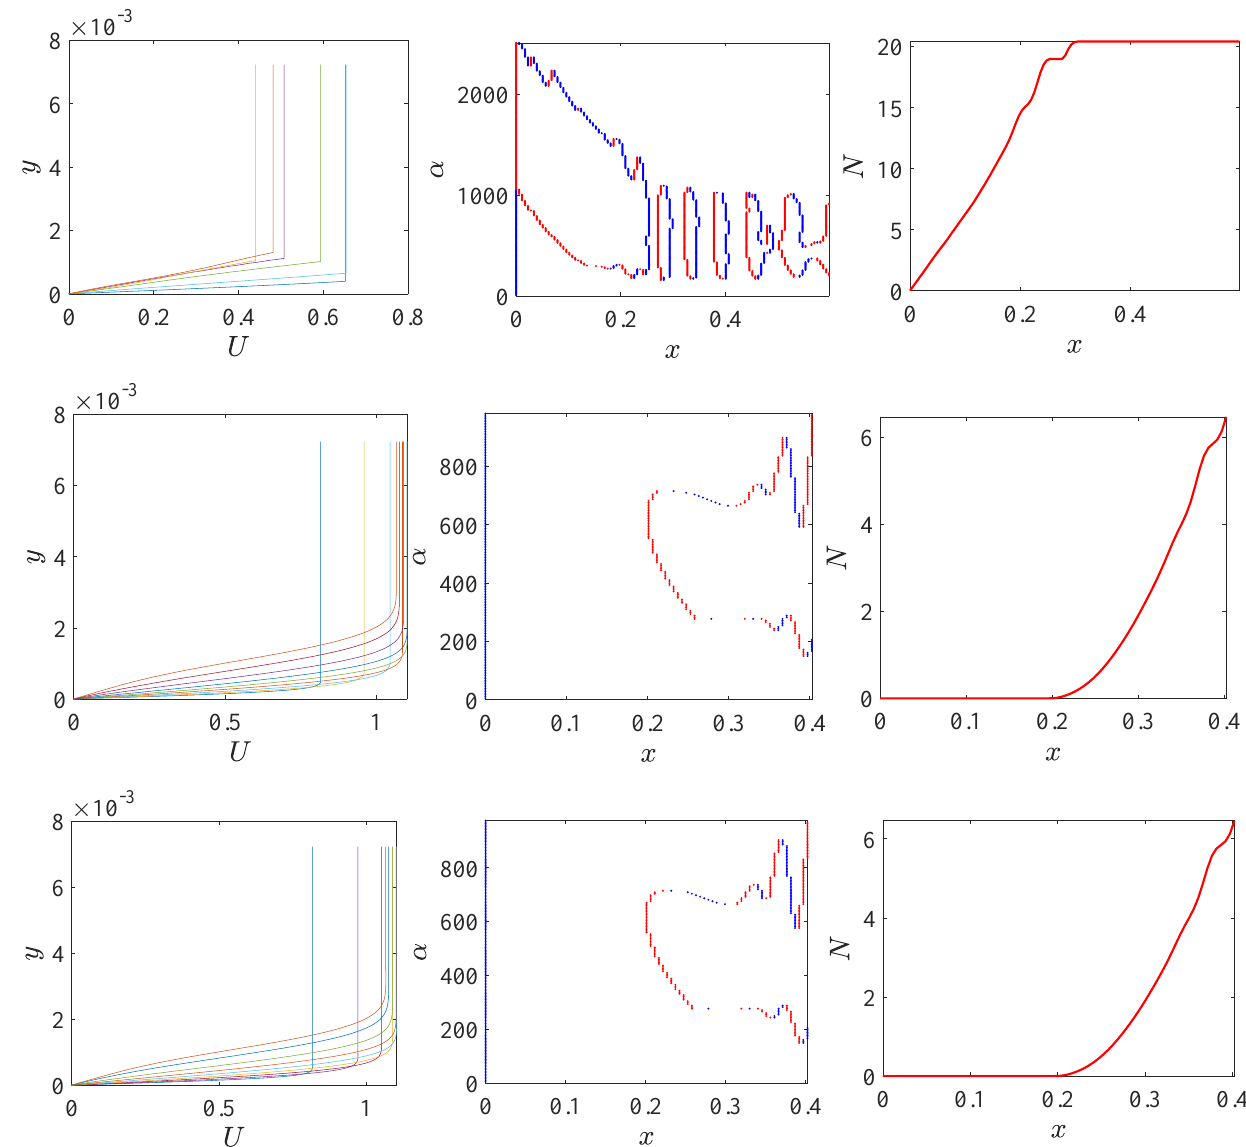
Figure 2. The U -profiles for each tenth normal of the wing slice ( left column ), the neutral curves of local temporal stability corresponding to the TS waves ( central column ; α is the local streamwise wave number of disturbances, the red and blue dots denote the beginning and end of the temporal instability region), the N -factor envelope of the growing disturbances ( right column ): U ∞ = 30 m/s, φ = 3 ◦ , tol H = 10 − 4 ( top row ), tol H = 10 − 5 ( middle row ), tol H = 10 − 6 ( bottom row